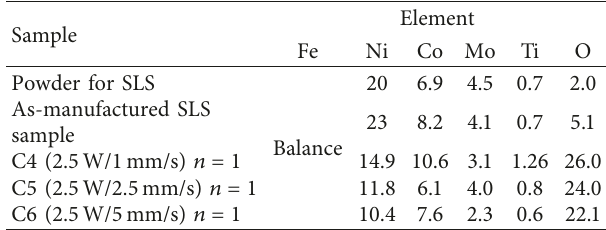
Figure 13: Friction coefficient curves of surfaces laser-processed 1, 2, 4, and 6 times (2.5mm/s; 2.5W). SLS: as-manufactured SLS sample. Table 4: Elemental composition of initial powder and surface of samples (by EDS, in